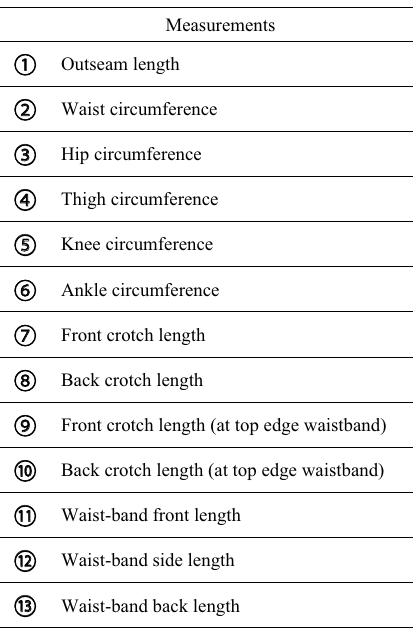
Table 2 Measurements of commercial